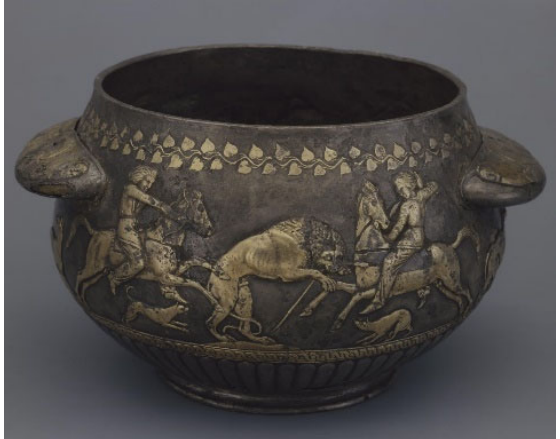
Figure 26. Vessel with lion hunting scenes (SHM inv. no. Дн .1913 ‐ 1/40); silver and gilt silver; Kurgan